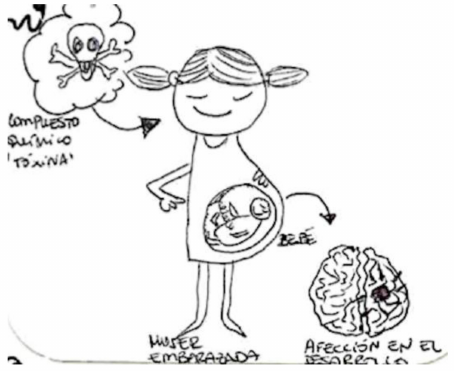
Figure 2. Breastfeeding, university education,